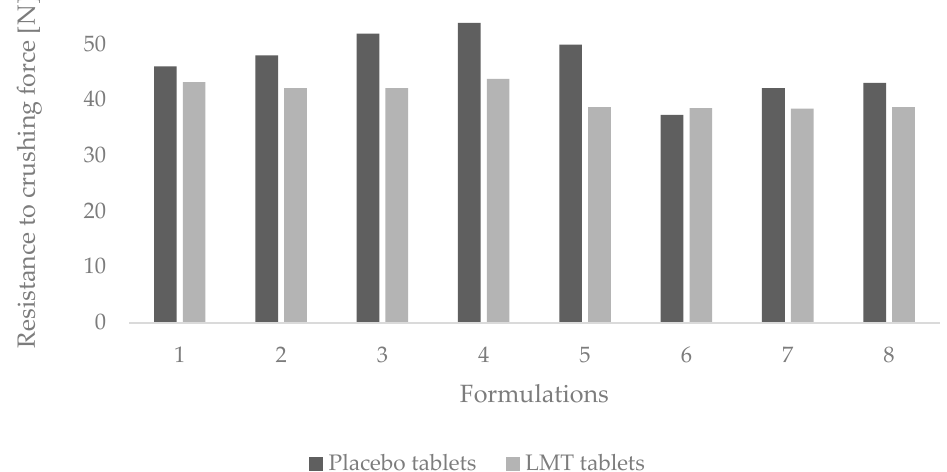
Figure 4. Resistance to crushing of LMT (F1–F8) and placebo tablets (T1–T8).